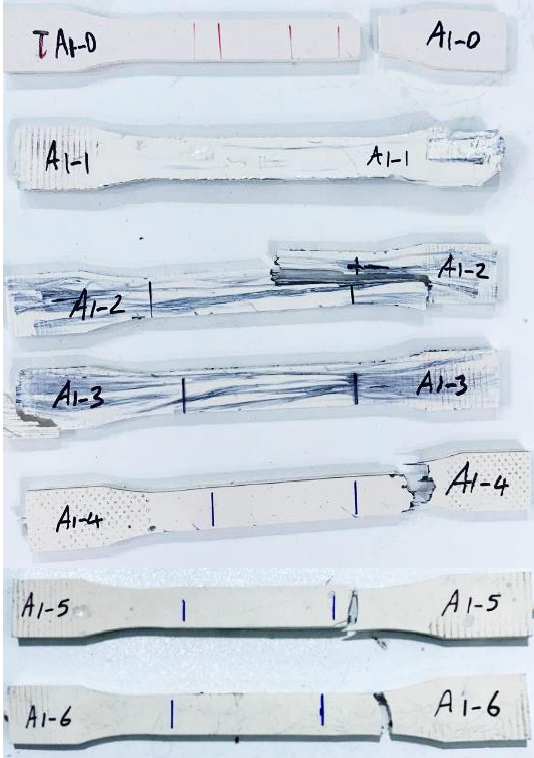
Fig. 9. Sample tested in tensile results.